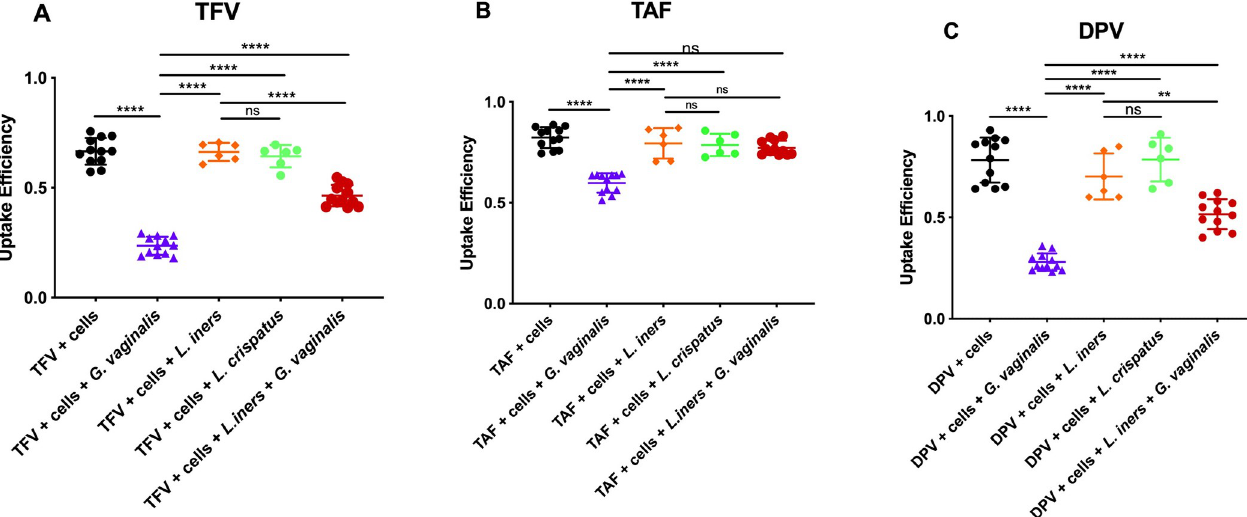
Fig 6. Uptake efficiency of Jurkat cells in converting drug into active metabolite after 1 hour. Uptake efficiency is defined as the amount of intracellular drug divided by the amount of drug added extracellularly. (A) Uptake efficiency of Jurkat cells in converting TFV into TFV-DP based on 1) TFV + cells alone (black) 2) TFV + cells + G . vaginalis (purple) 3) TFV + cells + L . iners (orange) 4) TFV + cells + L . crispatus (green) 5) TFV + cells + L . iners + G . vaginalis (red). Bacteria were added 15 minutes prior to incubation at 37C and added at a ratio of bacteria to cells of 2.5:1. Co-culture experiments (4) were added at a 1:1 ratio of L . iners : G . vaginalis and an overall ratio of total bacteria to cells at 2.5:1. N = 12. (B) Uptake efficiency of Jurkat cells in converting TAF into TFV-DP based on 1) TAF + cells alone (black) 2) TAF + cells + G . vaginalis (purple) 3) TAF + cells + L . iners (orange) 4) TFV + cells + L . crispatus (green) 5) TFV + cells + L . iners + G . vaginalis (red). Bacteria were added 15 minutes prior to incubation at 37C and added at a ratio of bacteria to cells of 2.5:1. Co-culture experiments (4) were added at a 1:1 ratio of L . iners : G . vaginalis and an overall ratio of total bacteria to cells at 2.5:1. N = 12. (C) Uptake efficiency of Jurkat cells in accumulating intracellular DPV based on 1) DPV + cells alone (black) 2) DPV + cells + G . vaginalis (purple) 3) DPV + cells + L . crispatus (orange) 4) TFV + cells + L . crispatus (green) 5) TFV + cells + L . iners + G . vaginalis (red). Bacteria were added 15 minutes prior to incubation at 37C and added at a ratio of bacteria to cells of 2.5:1. Co-culture experiments (4) were added at a 1:1 ratio of L . crispatus : G . vaginalis and an overall ratio of total bacteria to cells at 2.5:1. N = 12.